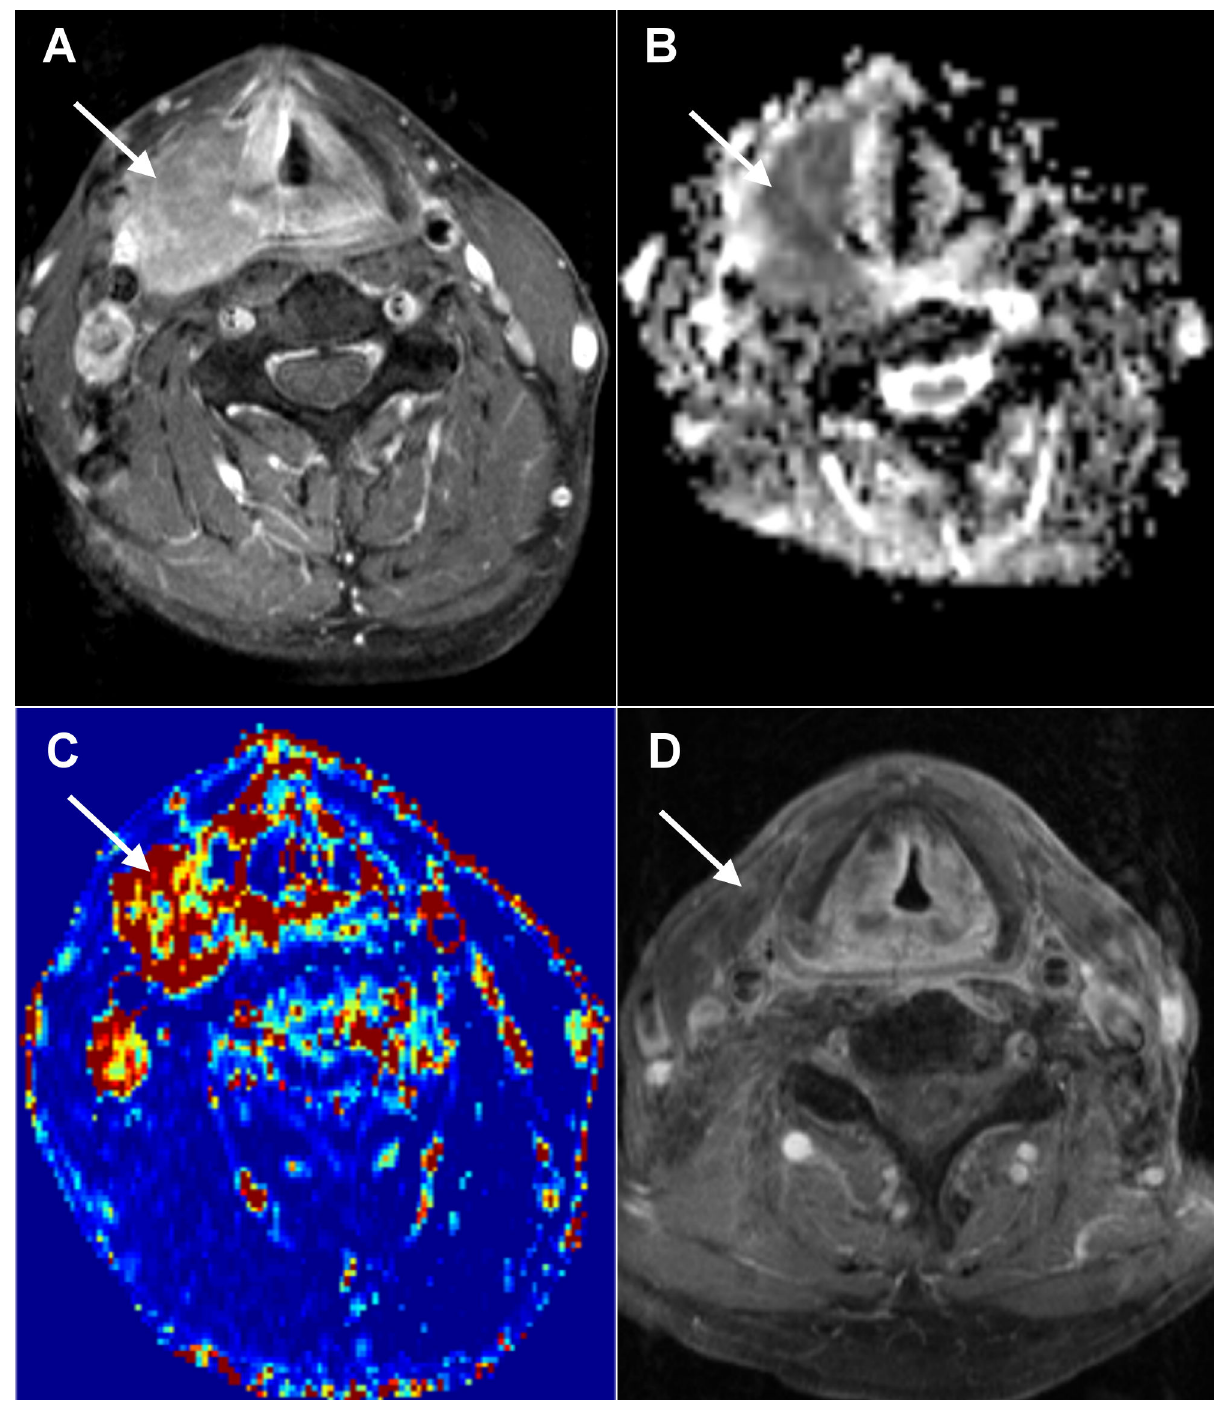
Figure 2. Local control in a 52-year-old man with hypopharyngeal SCC after chemoradiation. A. A pretreatment axial- enhanced MRI shows the right hypopharynx tumor (arrow). B. The corresponding PWI map shows the tumor with a K trans value of 0.614 min -1 . C. The corresponding ADC map shows the tumor with an ADC value of 0.98 × 10 -3 mm 2 /s. D. Post-treatment axial- enhanced MRI shows the regression of the right hypopharynx tumor. A 18-month clinical and imaging follow-up did not disclose any tumor growth.